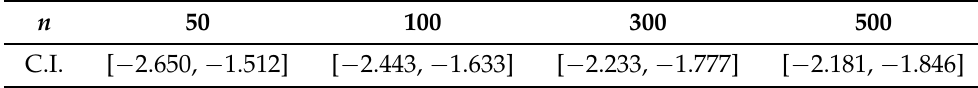
Table 3. The 95% confidence intervals for α 0 in case